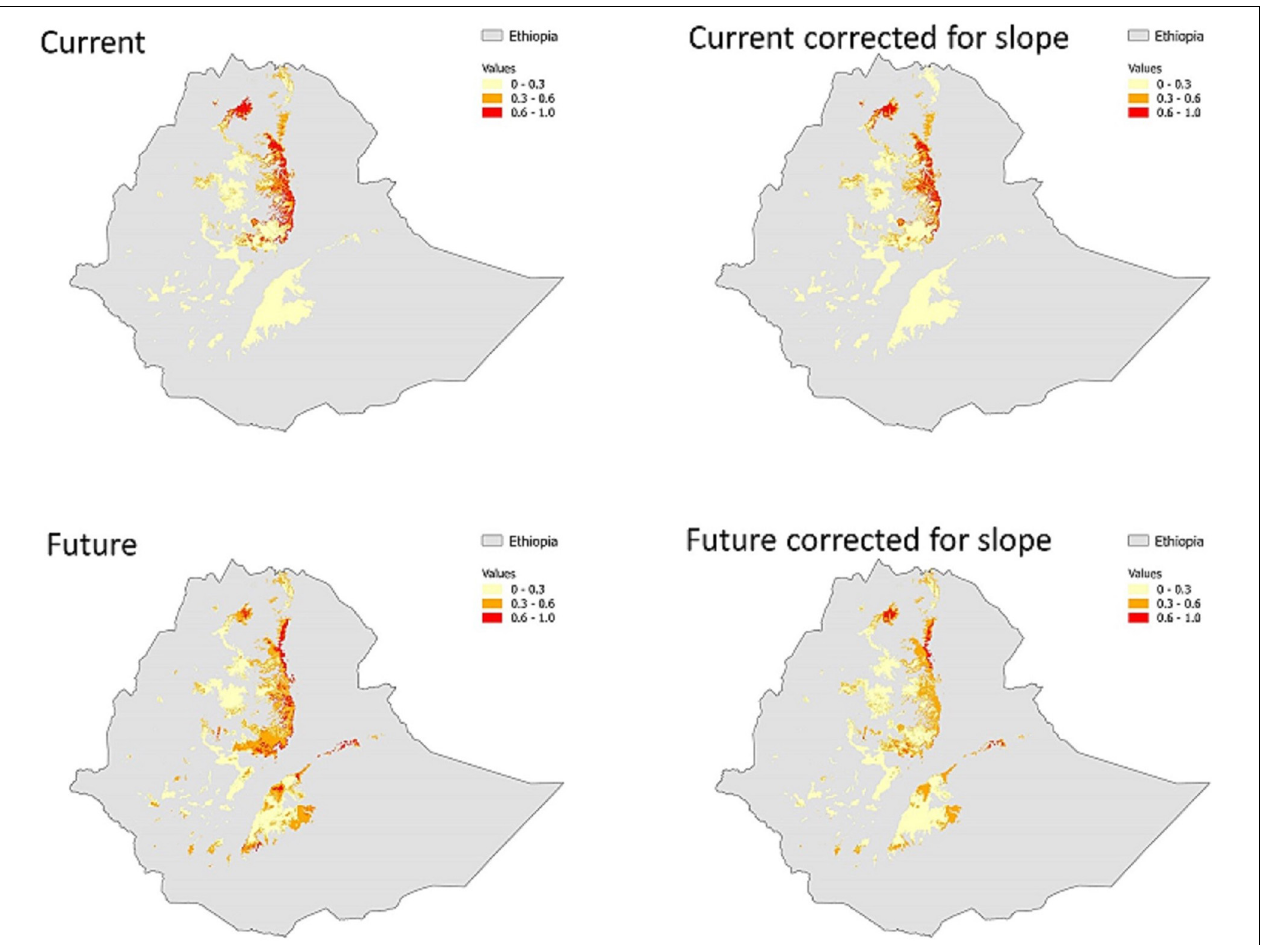
FIGURE 3 | Comparison of habitat suitability under current (upper panels) and future (lower panels) climates in Ethiopian highland masses ( > 2,300 m). Current suitability maps are produced by average nine maps (3 algorithms × 3 threshold values). Future habitat suitability is produced by averaging 72 maps (3 algorithms × 3 threshold values × 1 climate model × 4 emission scenarios). The numbers in the legend bar refer to the degree of agreement among maps in predicting presence: 0–0.3 unsuitable with high certainty, 0.3–0.6 uncertain suitability, > 0.6 suitable with high certainty. Slope is excluded as a predictor variable and correction is made for under-sampling of steep slopes in the maps on the right